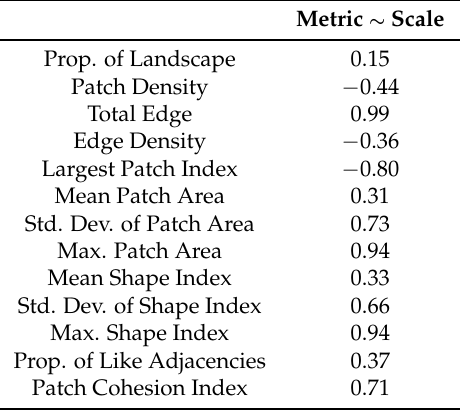
Table 3. Pearson’s correlation coefficients for metrics by the log of the dominant length scales. Some metric values have been log transformed according to the best fit